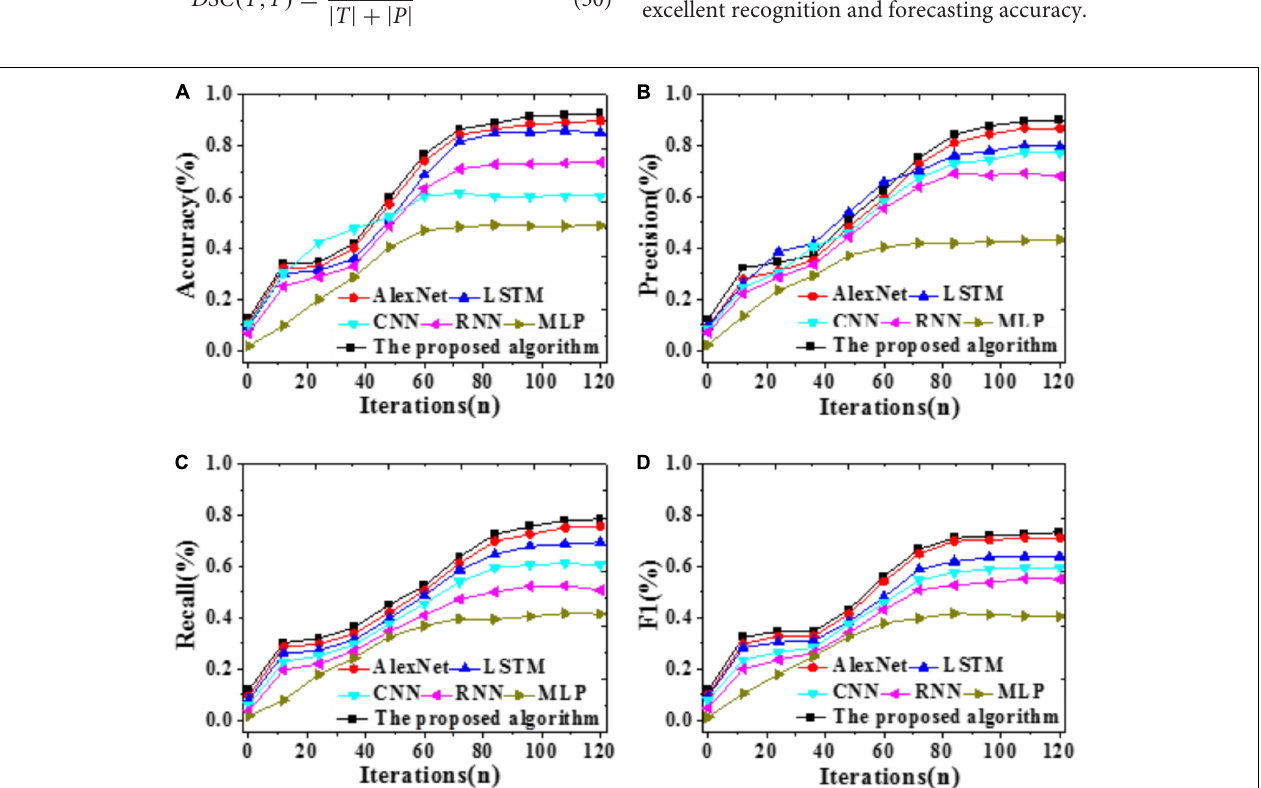
FIGURE 6 | Recognition accuracy of different models with iterations (A) Accuracy; (B) Precision; (C) Recall; (D) F1.